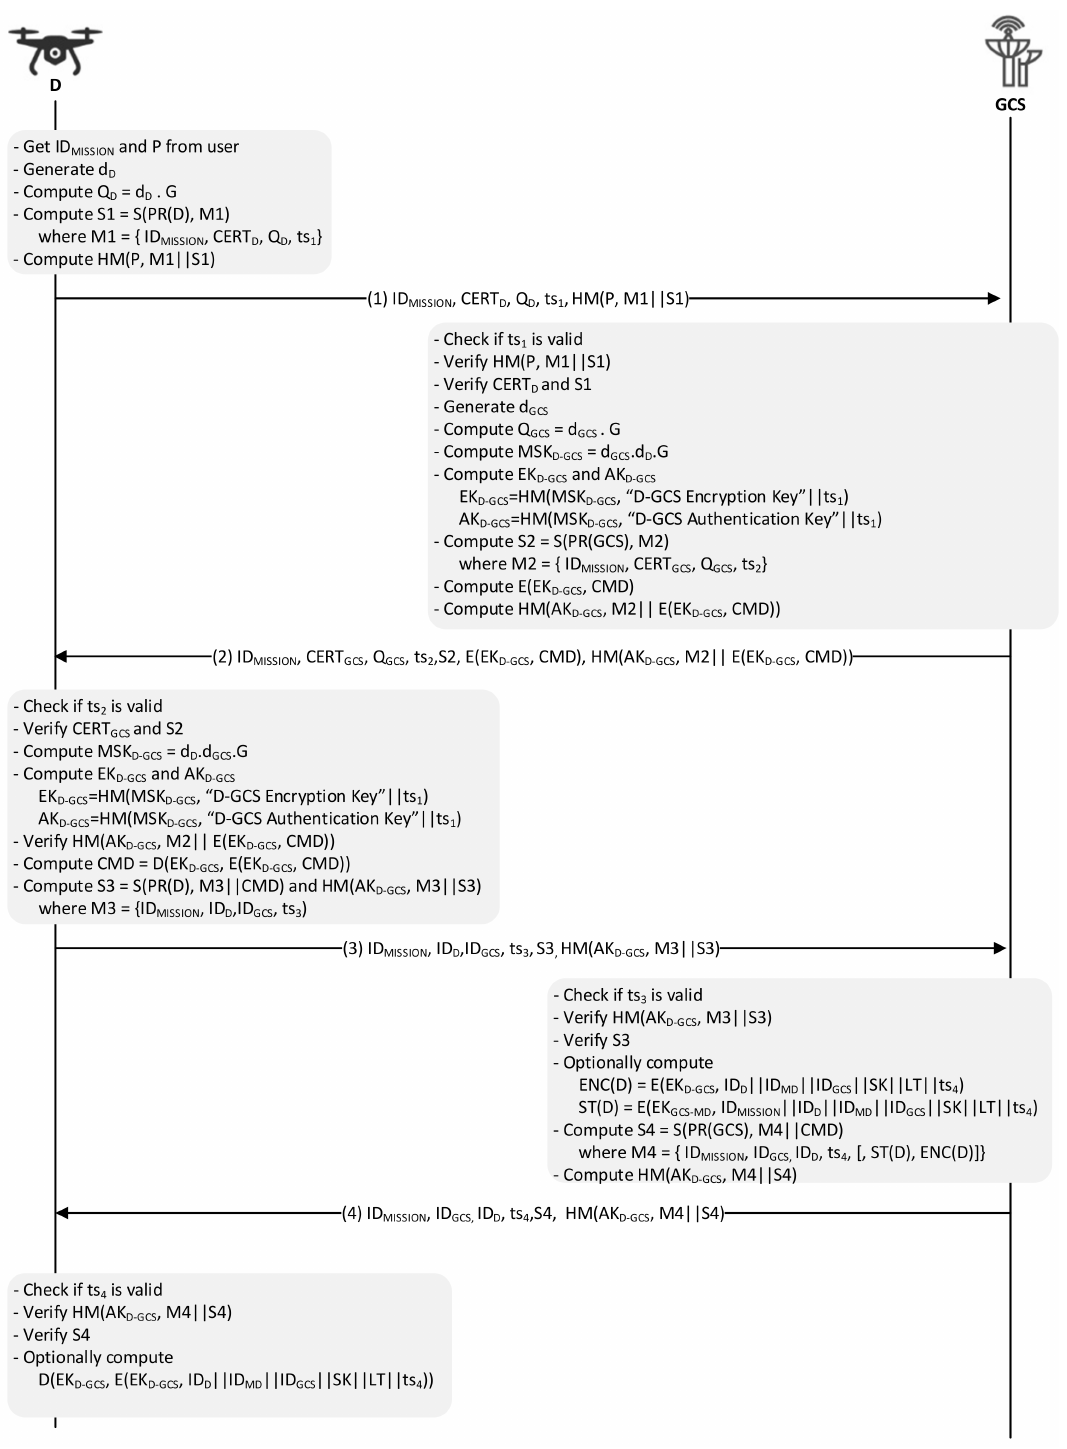
Figure 3. SP-D2GCS